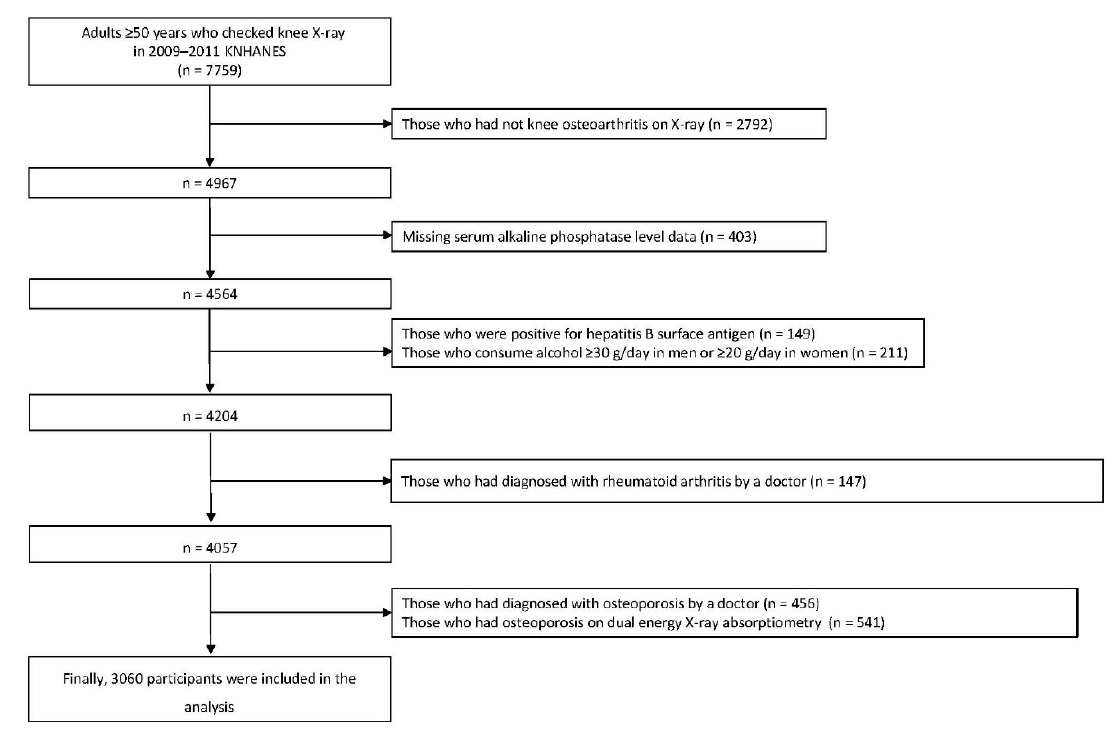
Figure 1. Flowchart of study population selection.